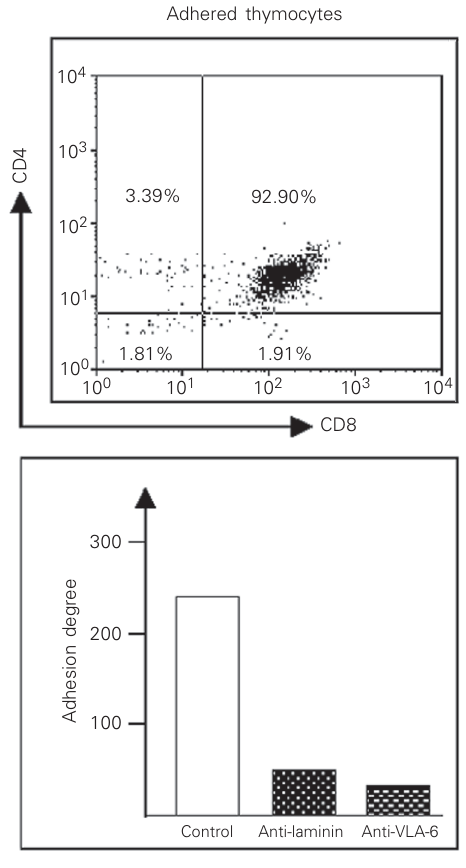
Figure 7. Extracellular matrix- driven thymocyte migration ex vivo . Freshly isolated mouse thymocytes were stimulated to migrate in transwells to which fibronectin or laminin had been added previously. Both extracel- lular matrix proteins enhance cell migration as compared to bovine serum albumin (BSA) used as negative